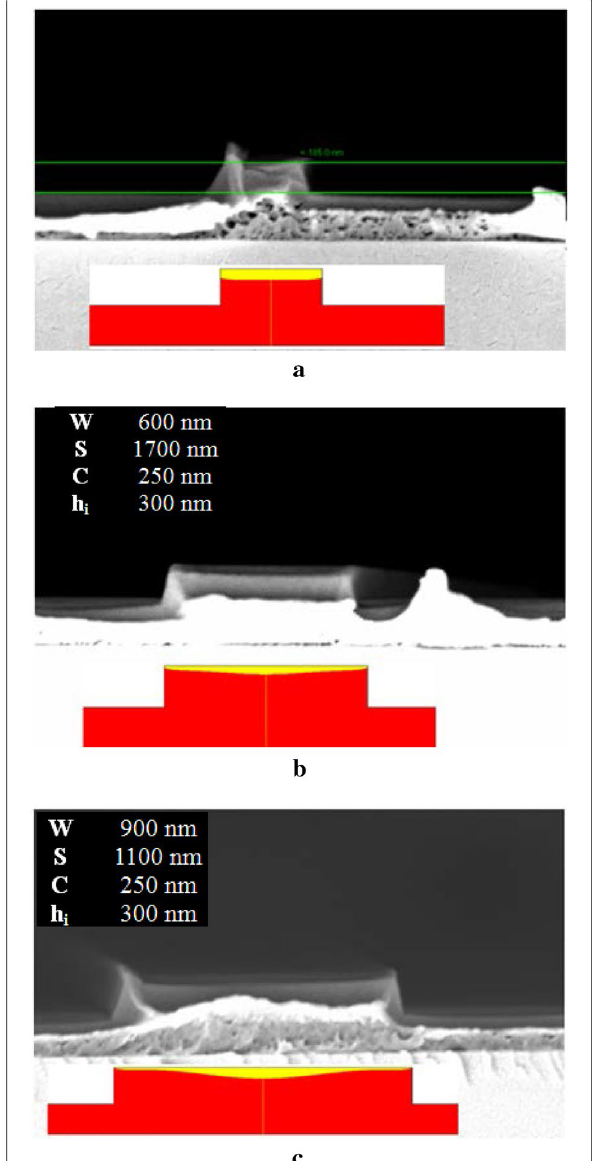
Fig. 5 Numerical and experimental polymer filling behaviors accord‑ ing to different dimensionless cavity size of a 0.15, b 0.26, and c 0.45 with 10 bar/s at 12.5 bar in 438